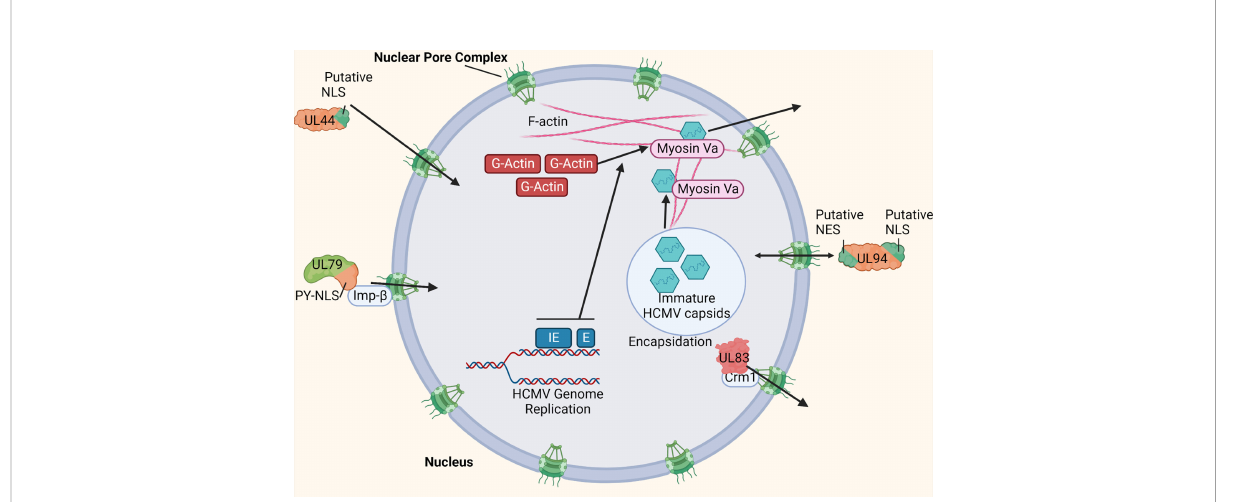
FIGURE 5 HCMV manipulates nuclear import and export machinery. HCMV uses various strategies to manipulate nuclear traf fi cking machinery for import and export. Some HCMV-encoded proteins such as UL44 mimic cellular NLS sites to achieve nuclear entry (101). Other HCMV-encoded proteins such as UL79 and UL84 contain a non-conventional NLS site (PY-NLS) that allow direct interaction with nuclear import machinery components such as Imp- b (100, 101). HCMV-encoded UL94 contains both a putative NLS an NES to manage ef fi cient bidirectional nuclear import and export (100). HCMV proteins such as UL83 has been shown to interact directly with nuclear export machinery (such as Crm1) to manage its export from the nucleus (100, 102). HCMV IE and E gene expression has been shown to induce the formation of F-actin within the nucleus (103). Additionally, myosin Va is recruited to the replication compartment during infection. Both myosin Va and nuclear actin fi laments are traf fi cking components required for nuclear egress of HCMV genome-containing capsids (103, 104). Made with